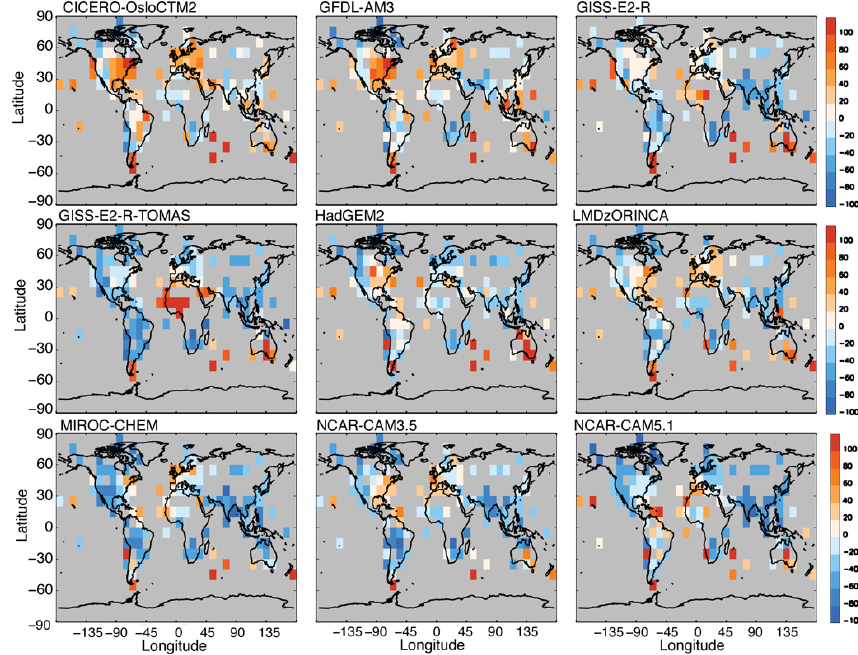
Fig. B1. Bias (%) in models for present-day annual average AOD relative to AeroNet for locations with AeroNet observations. Clear-sky AOD is used for the GISS-E2-R